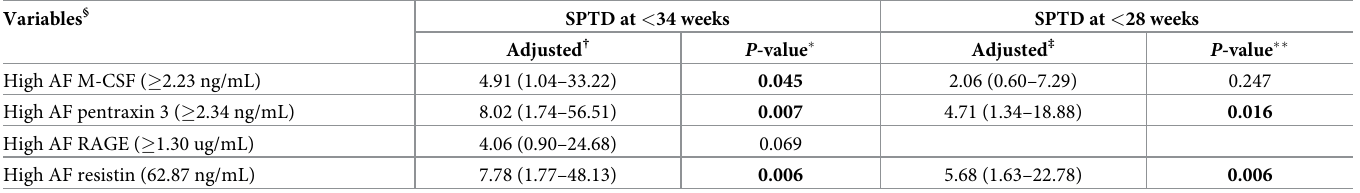
Table 3. Multivariate Firth’s logistic regression model showing the adjusted odds ratios of the association between the various amniotic fluid proteins and sponta- neous preterm delivery (SPTD) after cerclage placement.